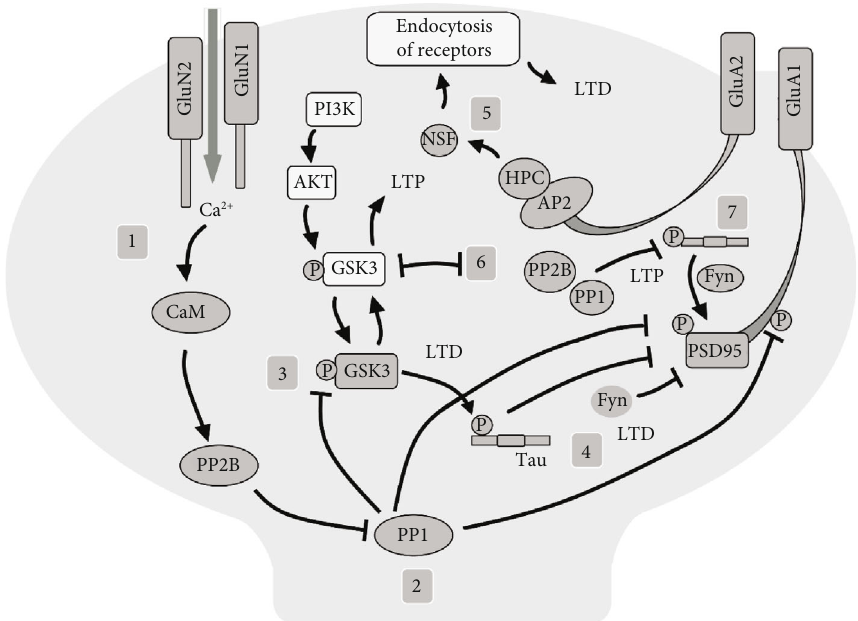
Figure 2: Tau phosphorylation and its involvement in long-term depression (LTD). (1) Calmodulin (CaM) detects a Ca 2+ increment due to NMDAr activation, leading to protein phosphatase-2B (PP2B) activation and the subsequent activation of the PP1. (2) PP1 dephosphorylates Ser845 at the AMPAr subunit GluA1, Ser295 at PSD95, and GSK3 β . (3) Active GSK3 β leads to pTau near MD (microtubule domain). (4) pTau induced LTD by the dissociation of Tau/Fyn/PSD95 complex. (5) Dissociation of Tau/Fyn/PSD95 leads to disruption of interaction between GluA2 and with N-ethylmaleimide-sensitive factor (NSF) that cause clathrin-mediated endocytosis of receptors during NMDAr-LTD. (6) Inactive GSK3 β (through the PI3K/AKT pathway) and dephosphorylated Tau (that recruits Fyn kinase to target the PSD95/NMDAr complex) promote long-term potentiation (LTP) ( arrow = activation , flatline = inhibition